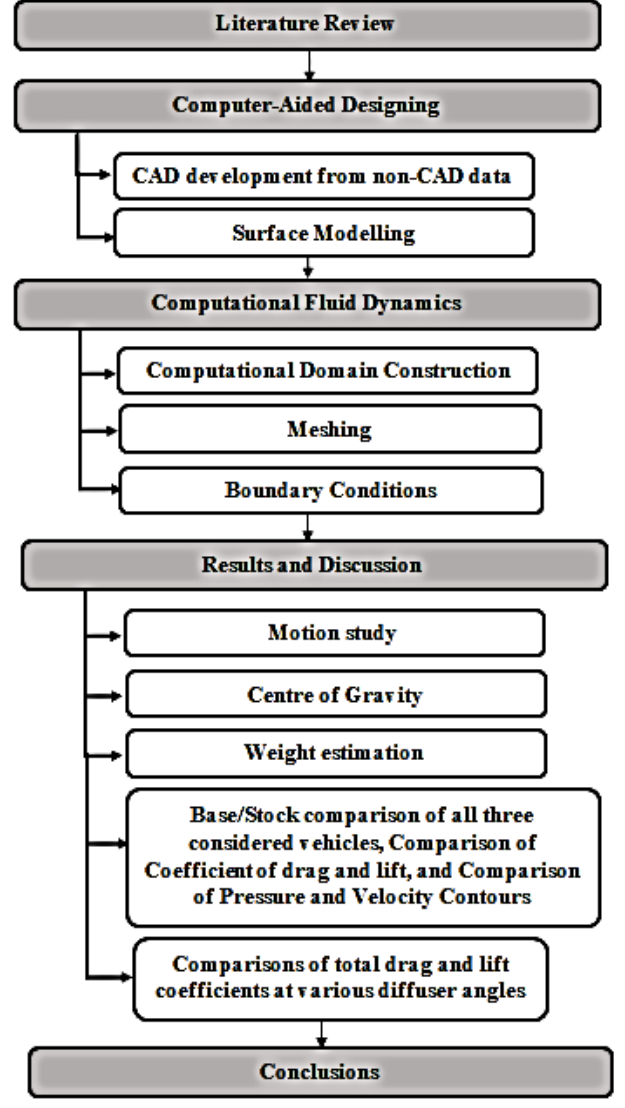
Fig. 2. Research methodology